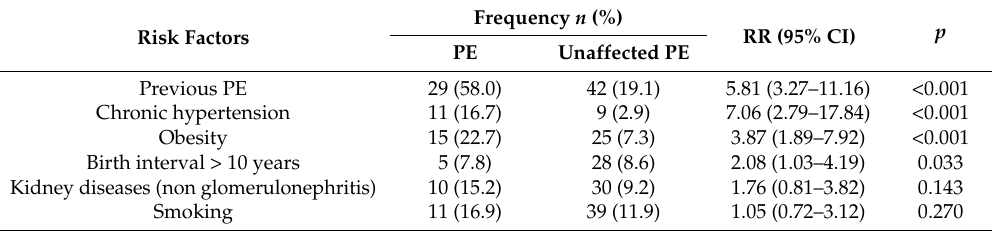
Table 4. Independent risk factors of medical history for development of PE at the first trimester.